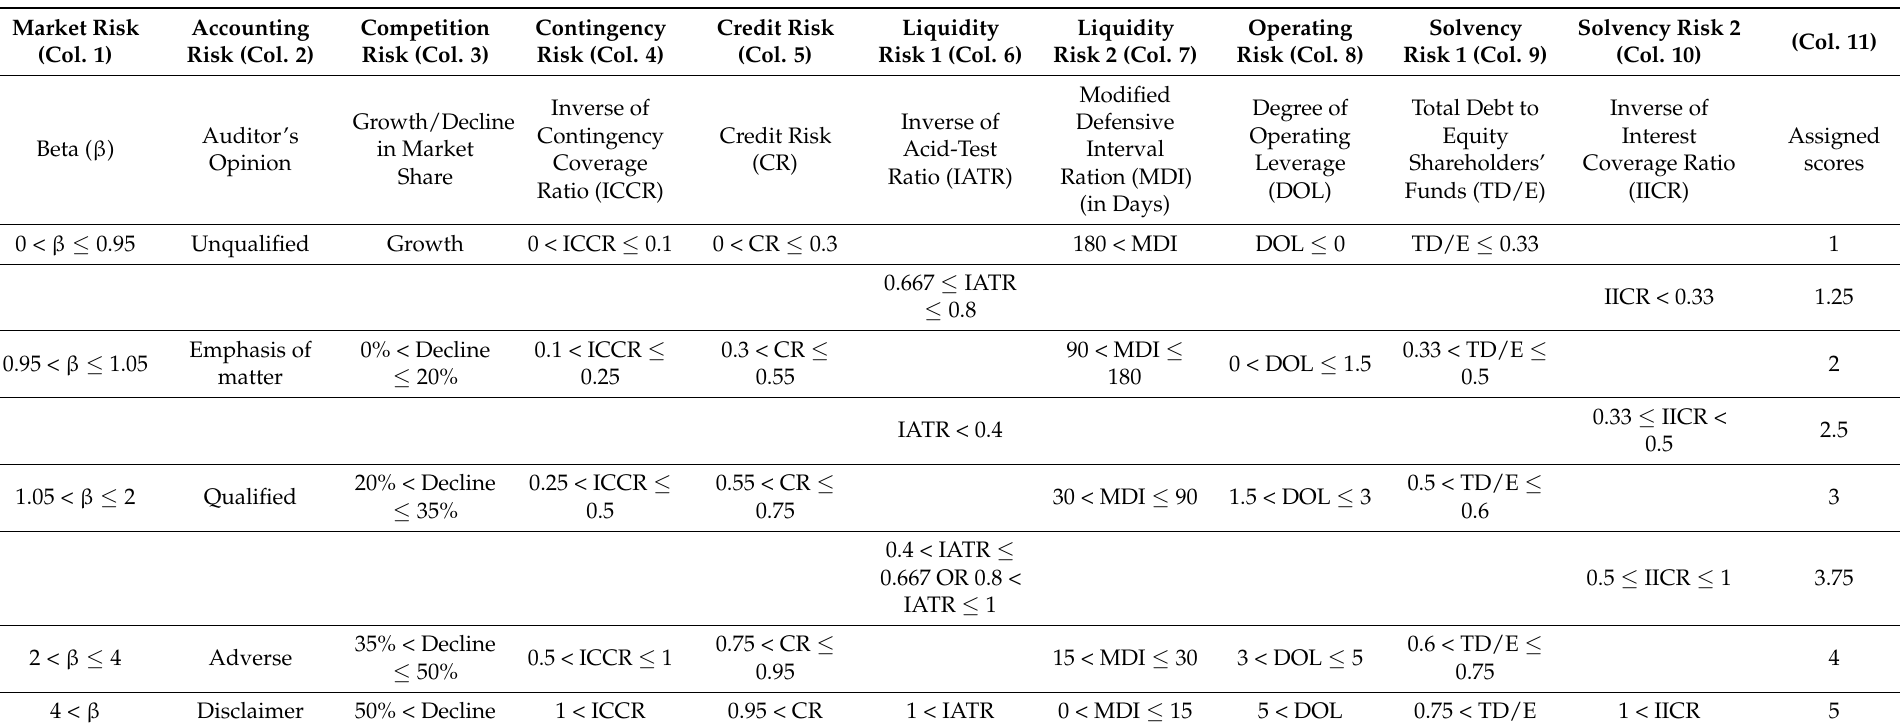
Table 1. Risks and their corresponding scales used in the construction of the risk